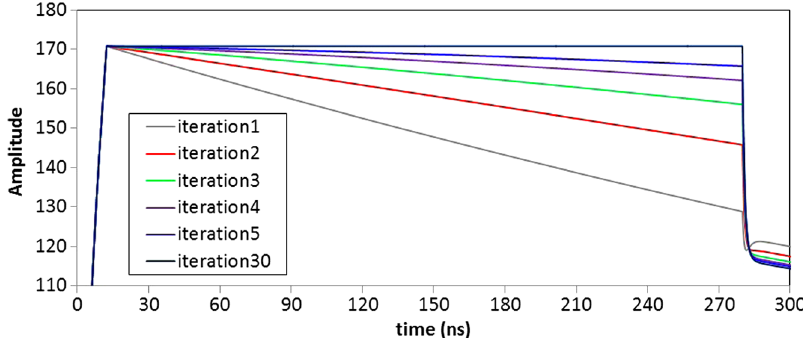
0 . 5 and α 0 . 0 p ¼ i ¼